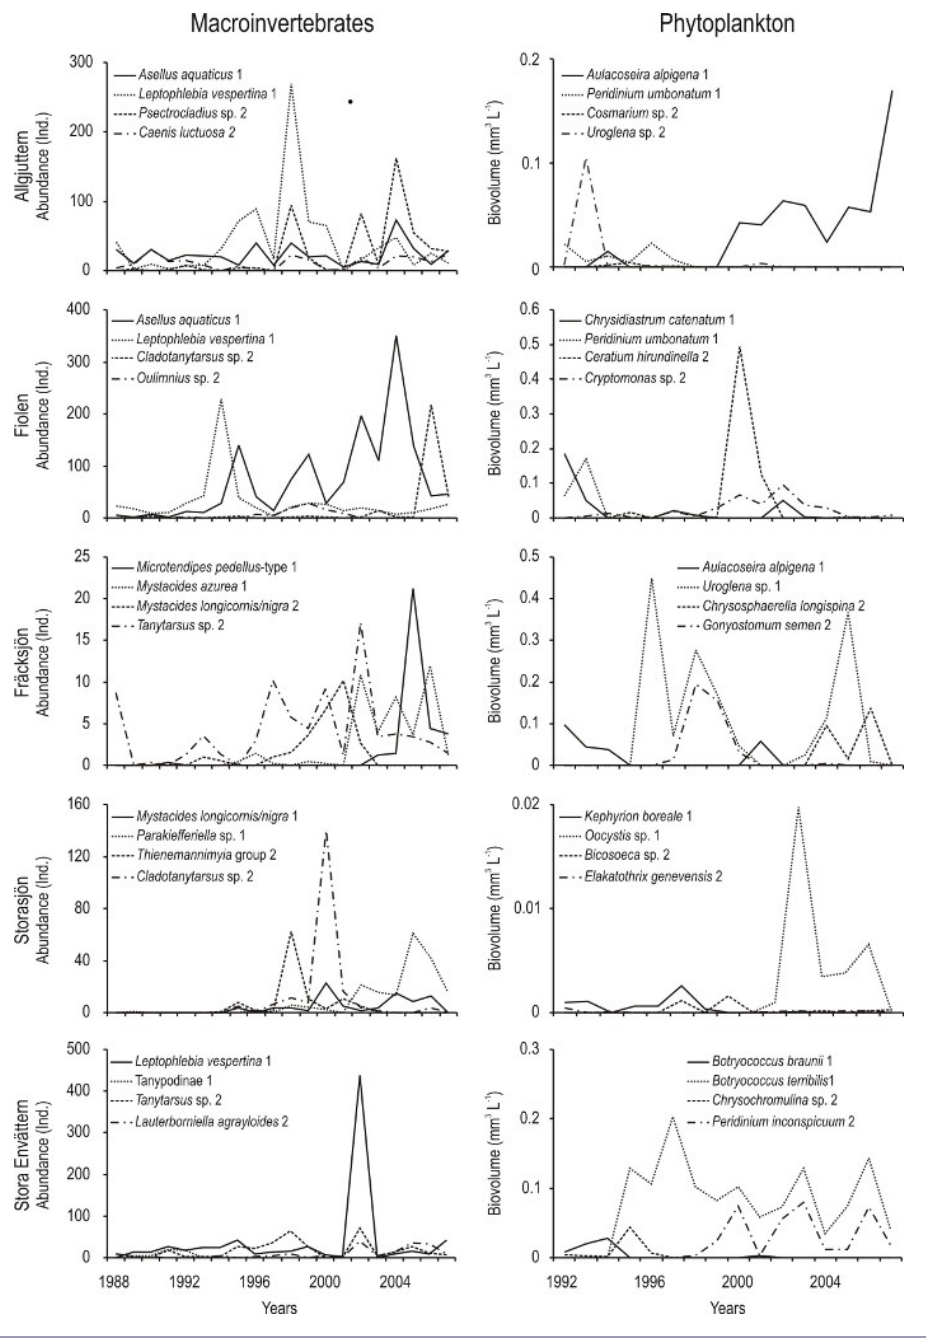
Fig. 2 . Temporal trends of invertebrate and phytoplankton populations in selected lakes, which contributed to the temporal patterns associated with the canonical axes 1 and 2 in the redundancy analysis models. The species were chosen based on their highest loading to redundancy analysis axes. The numbers after the species names indicate whether the species loaded to redundancy analysis axis 1 or